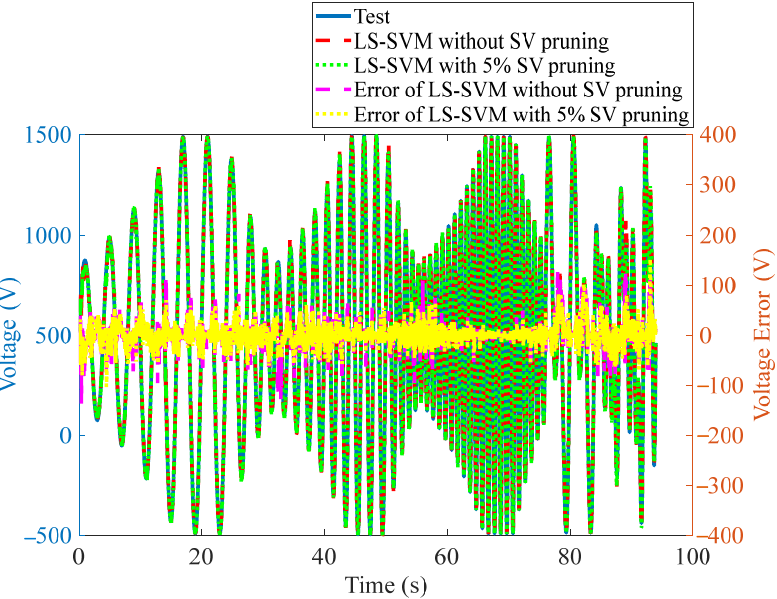
Figure 11. Predicated driving voltages of LS-SVM with and without SV pruning. Based on the hysteresis compensation LS-SVM model with SV pruning and the inverse model of BW-H, the constant frequency, multi-frequency superposition, variable frequency, and amplitude excitation voltages are predicted, and the prediction voltages and their errors are shown in Figure 12a–e, respectively. The prediction REs are listed in Table 2.